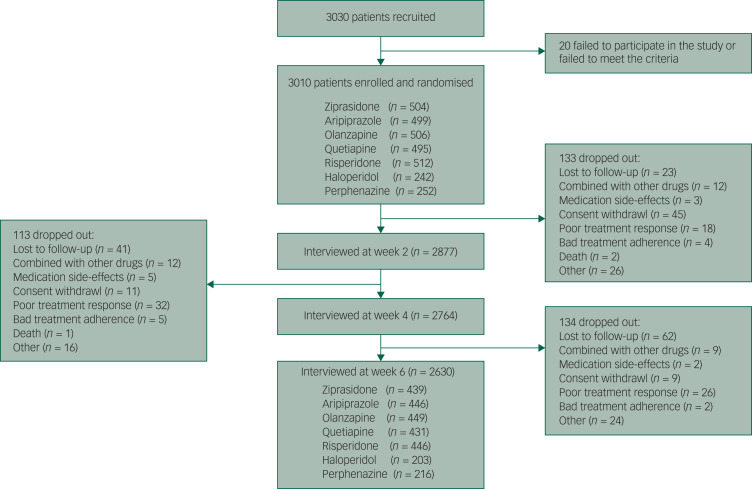
The trial profile.